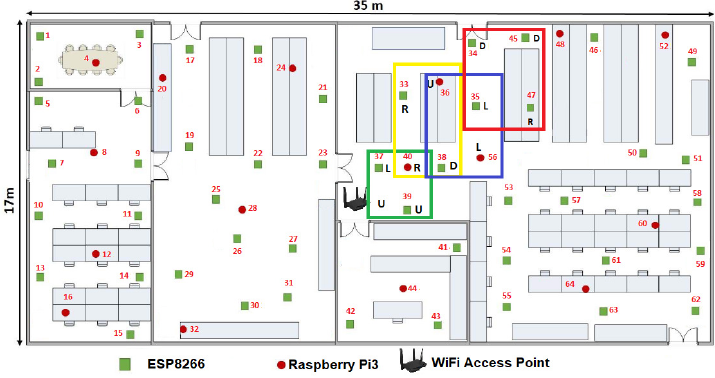
Figure 15. MCU 35 ( t 3 ) as the MCU using the axiom D −→ RDDL